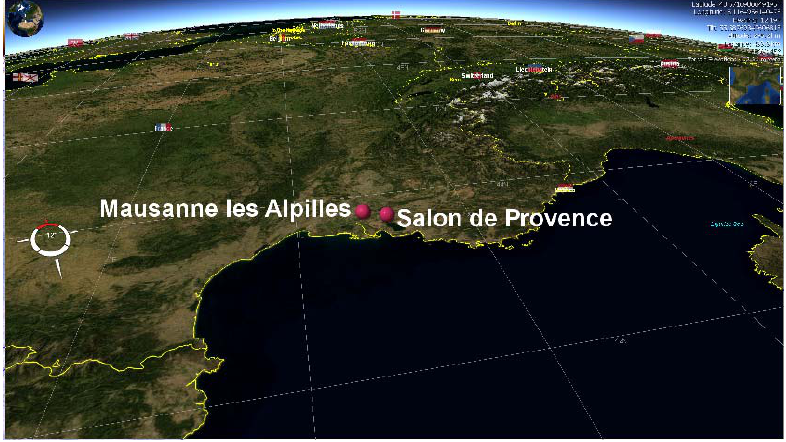
Figure 5. French C-SAP test fields of Mausanne les Alpilles and Salon de Provence (view made with NASA World Wind ®